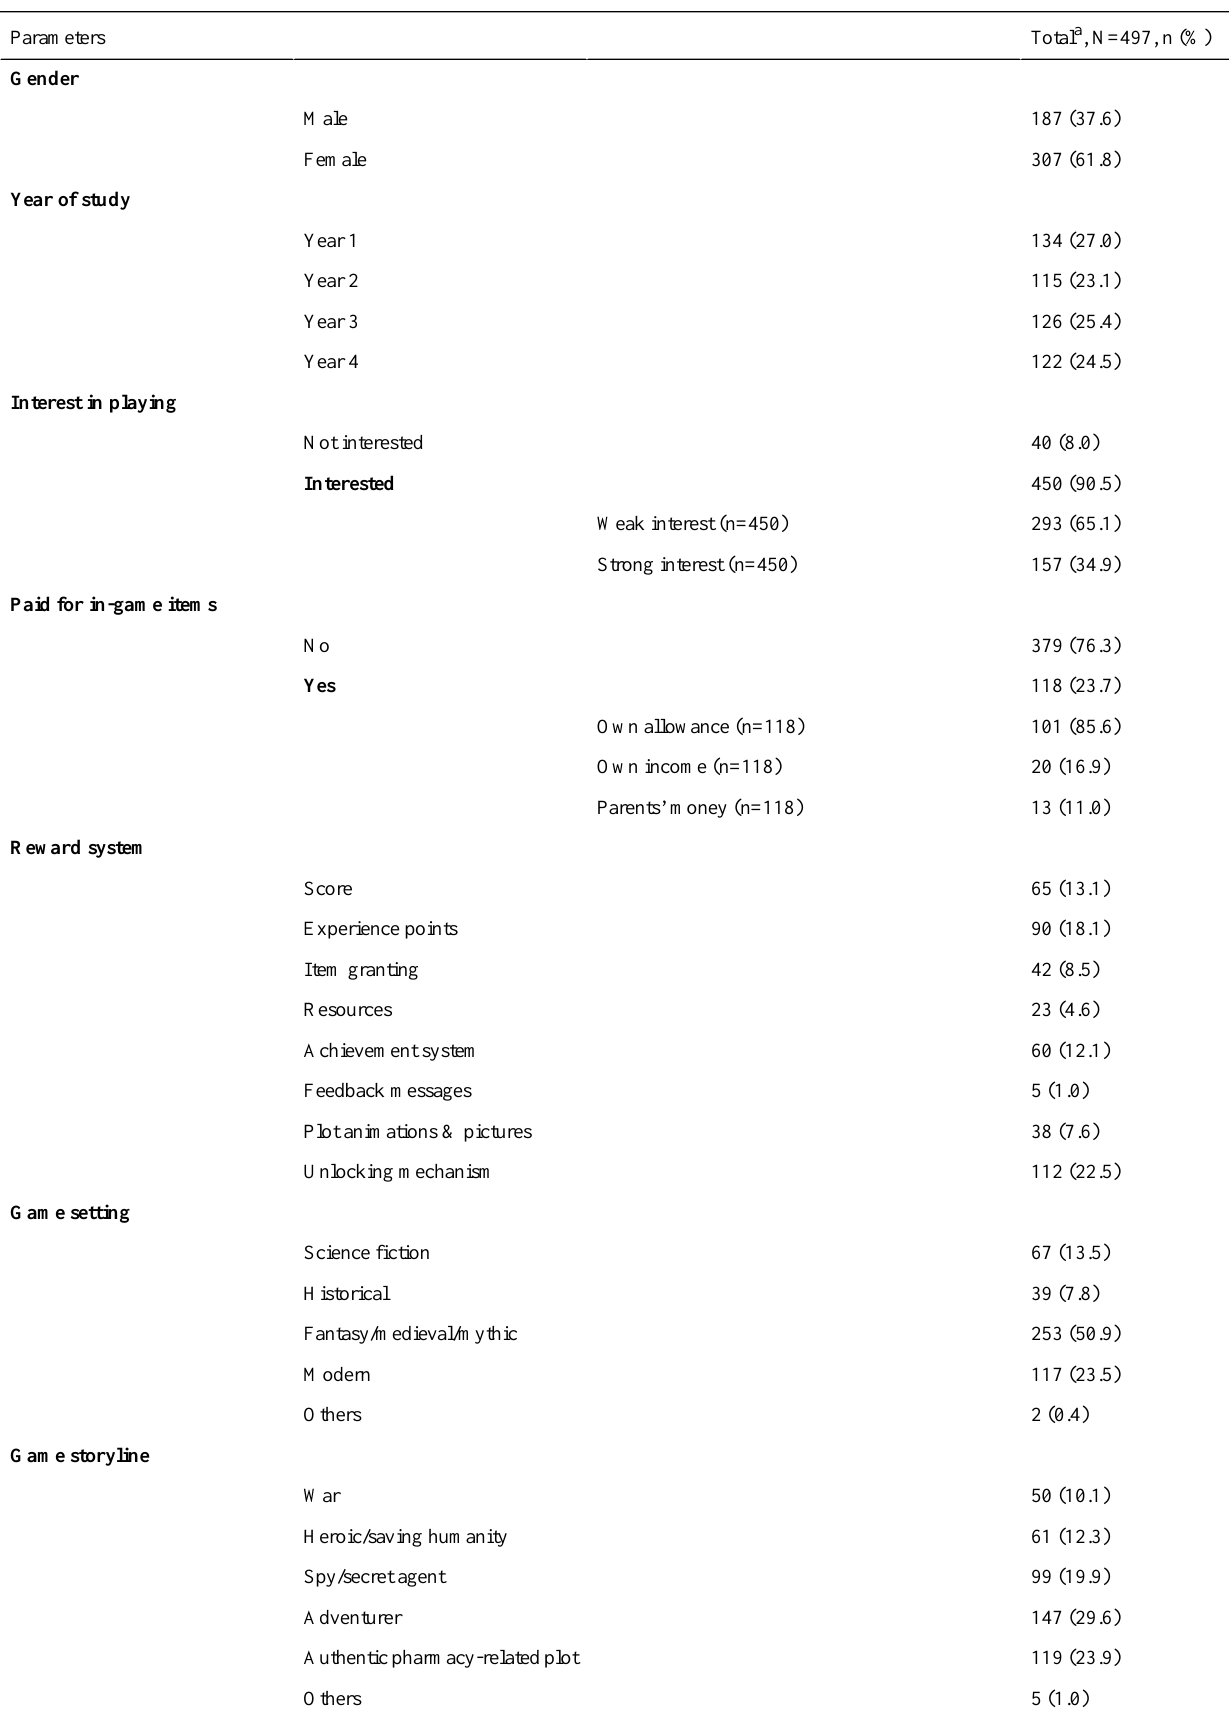
Table 1. Demographics and preferred gaming aspects of